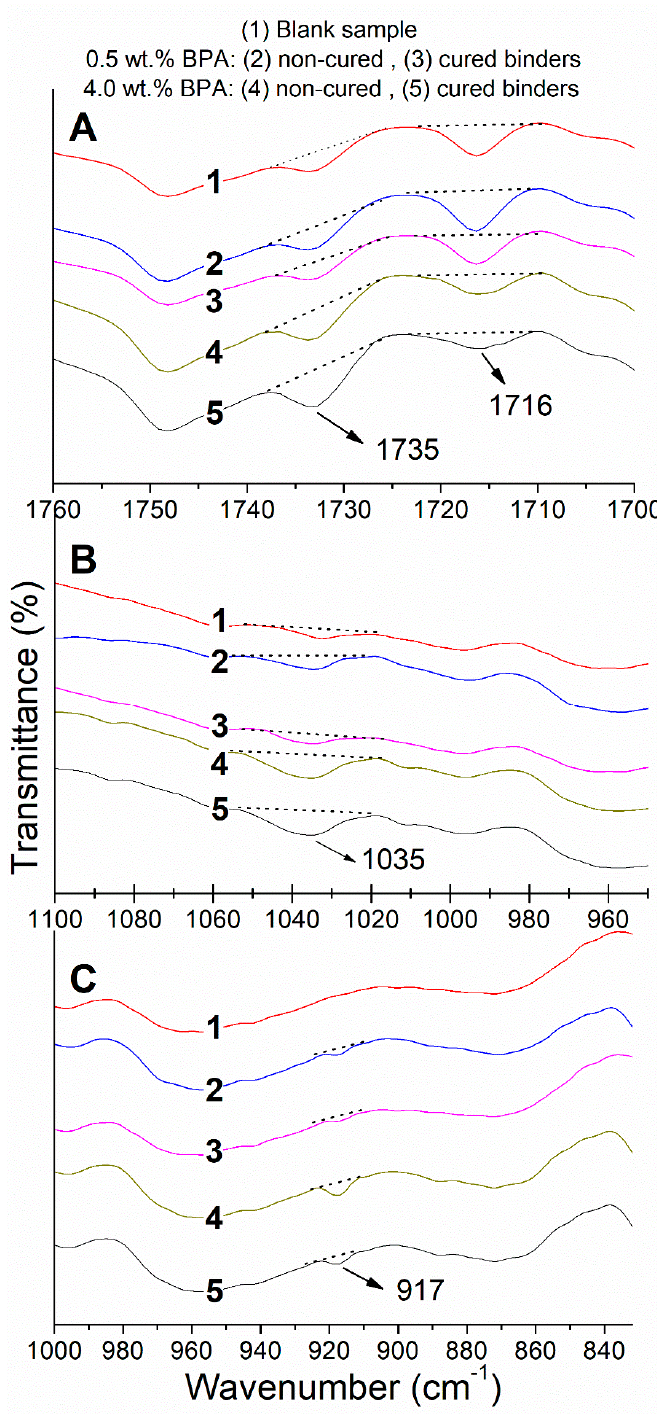
Figure 6. FTIR spectra for selected epoxy-modified binders and blank sample in three di ff erent intervals: ( A ) 1760–1700 cm − 1 , to evaluate carbonyl acid and ester groups at 1716 and 1735 cm − 1 , respectively; ( B ) 1100–950 cm − 1 , and ( C ) 1000–830 cm − 1 to evaluate the ether and oxirane groups at 1035 and 917 cm − 1 , respectively. Dotted lines have been used to mark the corresponding peak area.